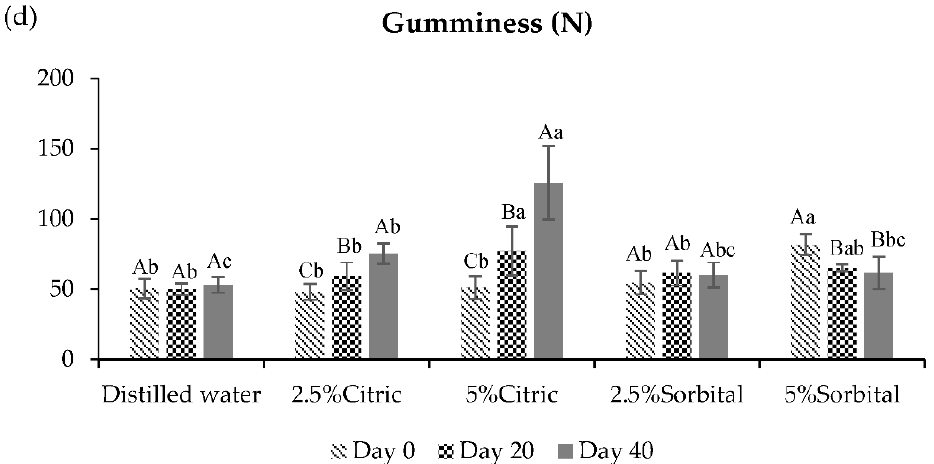
Figure 4. Texture profile analysis (TPA) of frozen fish fillets soaked with different solutions after thawing during storage times. ( a ) Hardness; ( b ) cohesiveness; ( c ) springiness; ( d ) gumminess. Different small superscript letters on the bar are significantly different ( p < 0.05) with respect to the treatment. Different capital superscript letters on the bar are significantly different ( p < 0.05) with respect to the period of storage. The results are reported as mean ± SD (n = 5).